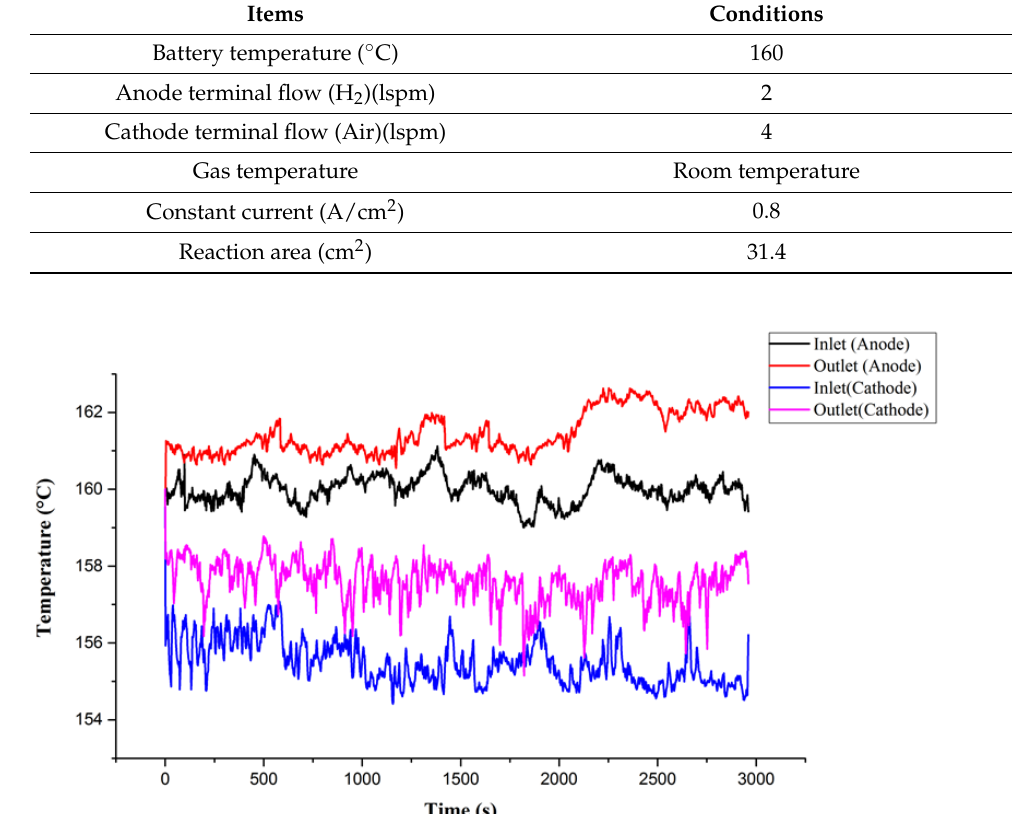
Figure 10. Temperature changes of HT-PEMFCs at different positions.